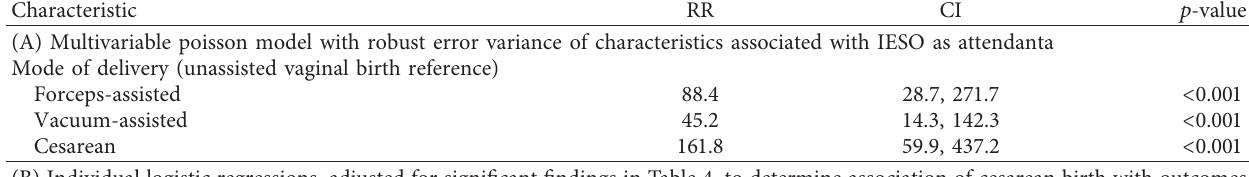
Table 2: (A) Multivariable model of characteristics associated with IESO attendant and (B) how outcomes are impacted by delivery by IESO as compared to midwife attendant. (A) Multivariable poisson model with robust error variance of characteristics associated with IESO as attendanta Mode of delivery (unassisted vaginal birth reference)